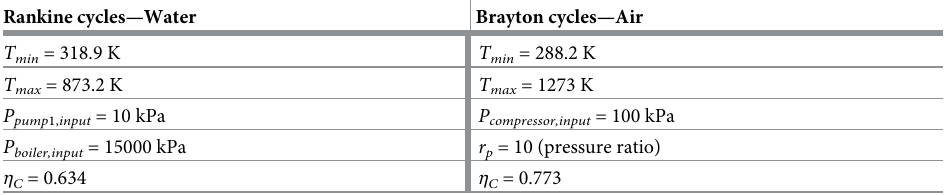
Table 1. Initial state point data used for the ideal Rankine and Brayton